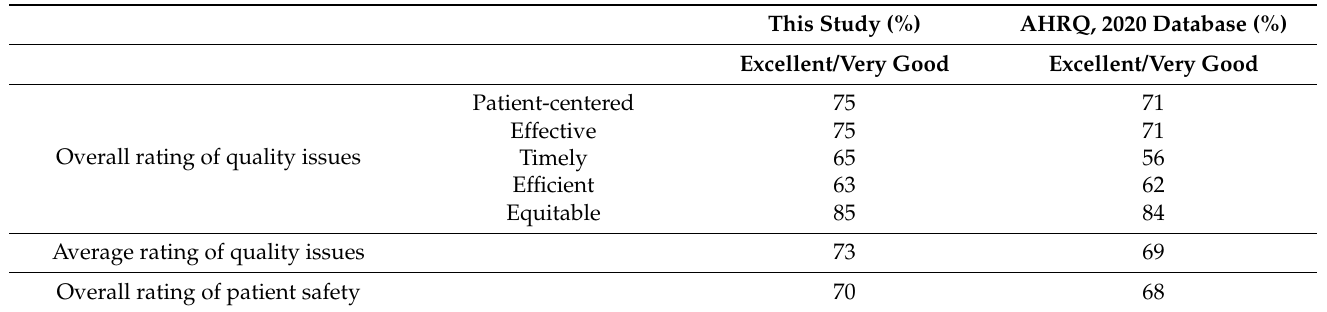
Table 4. Overall rating of quality and safety in the current study ( n = 459) as compared with the 2020 Medical Office Database ( n =